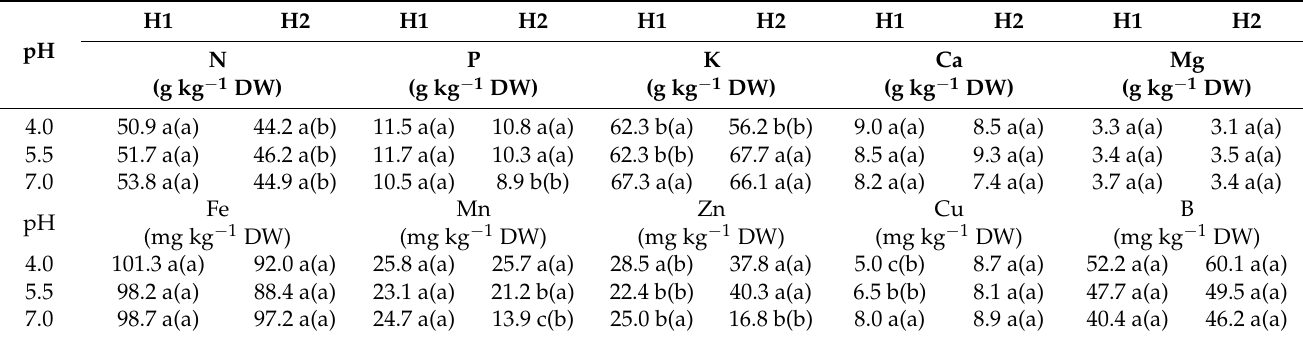
Table 2. Leaf nutrient concentrations of Taraxacum officinale plants grown under different nutrient solution pH, harvested at H1 (16-DAST) and H2 (29-DAST: Days after the Start of pH Treatment).